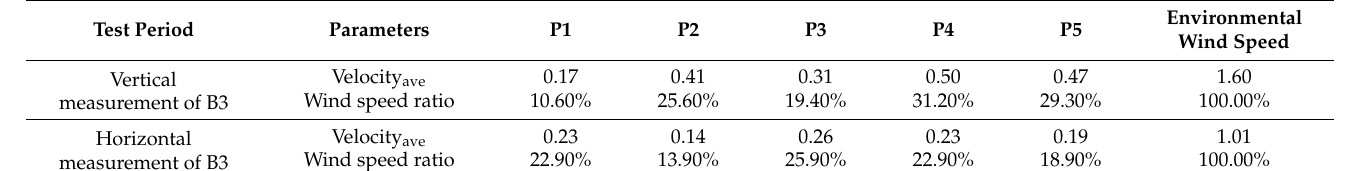
Table 5. Calculation summary of the wind speed of B3 in summer.